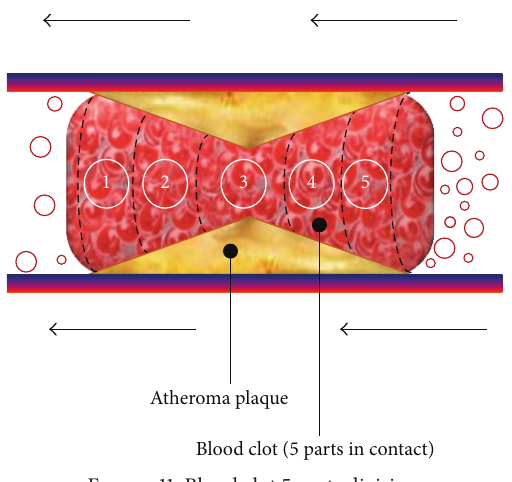
Figure 11: Blood clot 5 parts division.